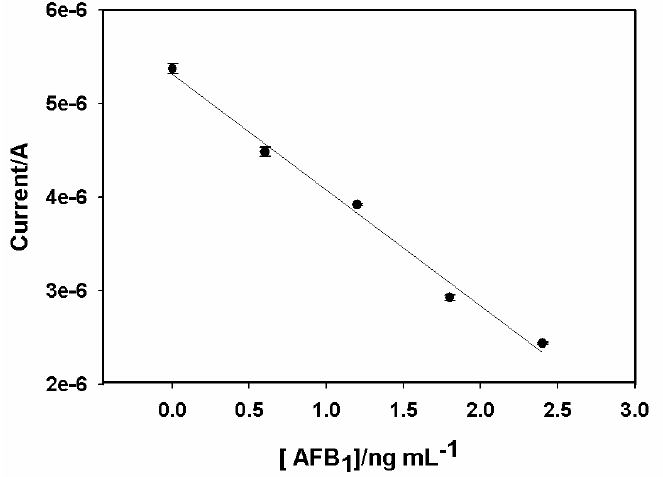
DPV responses of AFB conjugate|HRP-blocked), for 0 - 3 ng/mL AFB acetate buffer (pH 6.5) containing 3.2 µM of H